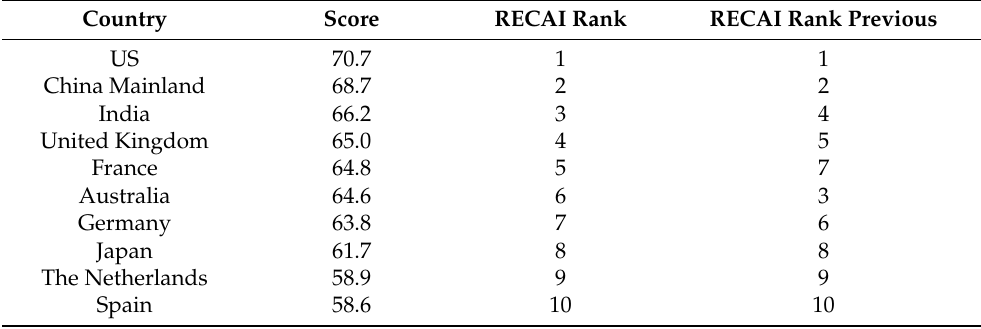
Table 2. Country ranking on RECAI score.